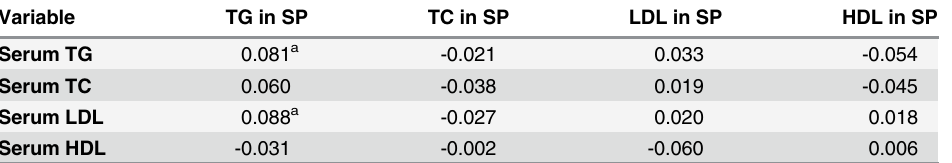
Table 3. Nonparametric (Spearman) correlation coefficients for the relationship between lipids levels in serum and seminal plasma for 631 subfertile men.